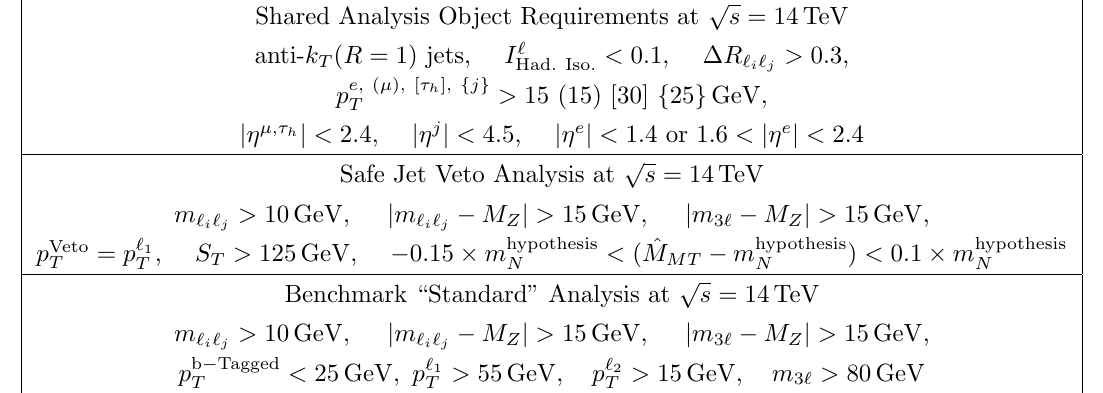
Table 6. Summary of p s = 14 TeV (top) analysis object requirements; (middle) selection cuts for safe jet veto analysis (this study); and (bottom) selection cuts for benchmark